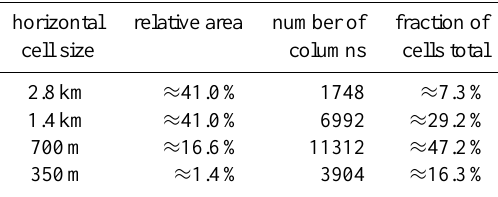
Hatchings correspond to different grid sizes.